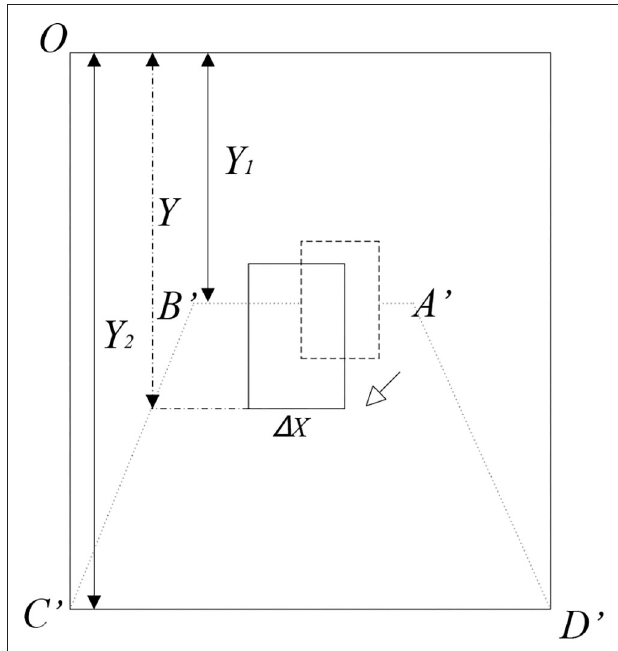
FIGURE 6 | Object movement in the